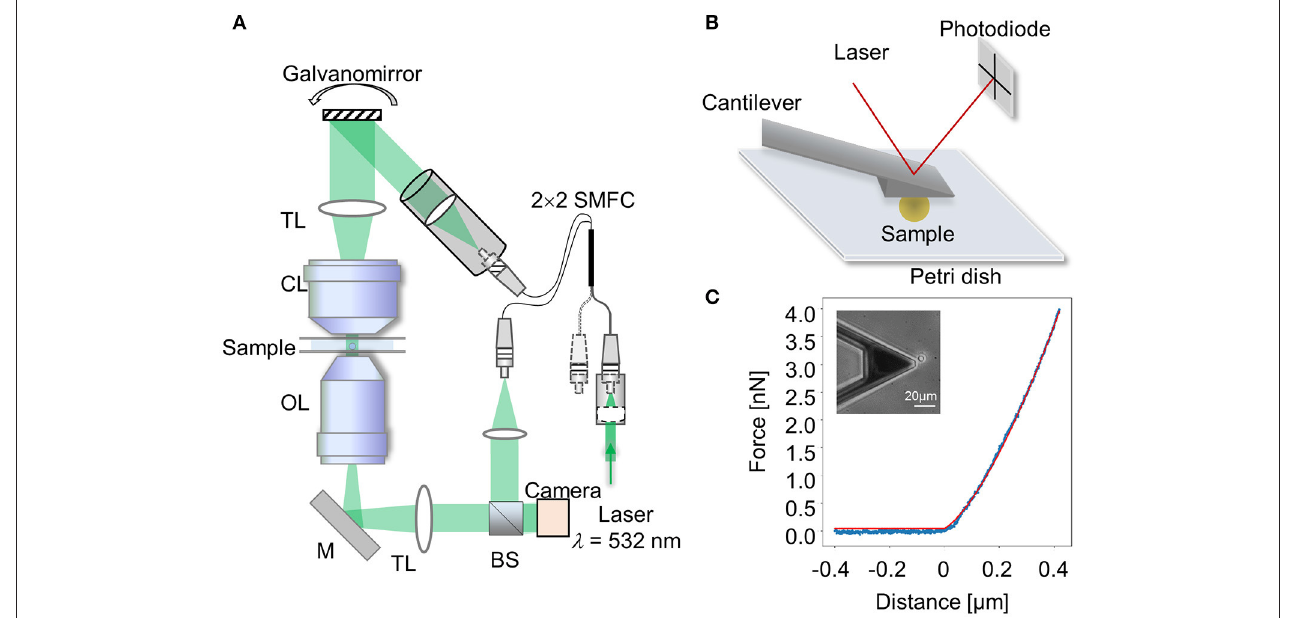
FIGURE 1 | Experimental setups. (A) Schematic diagram of the optical setup for optical diffraction tomography (ODT). SMFC, single-mode fiber coupler; TL, tube lens; CL, condenser lens; OL, objective lens; M, mirror; BS, beam splitter. (B) Schematic diagram of atomic force microscopy (AFM) using a wedged cantilever to indent a spherical sample. (C) Representative force-distance curve (blue dotted line) recorded during compression with a wedged cantilever shown in inset. Hertz model fit (red solid line) to extract the apparent Young’s